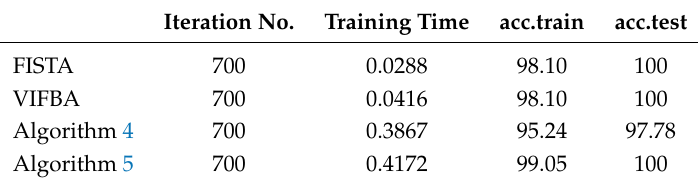
Table 10. The performance of each algorithm at the 700th iteration. Iteration No.